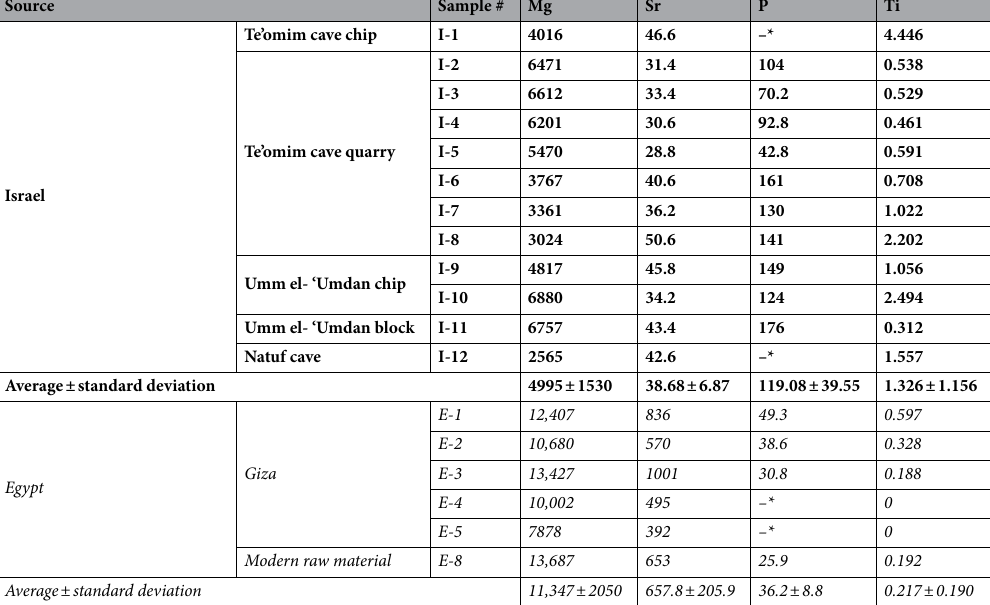
Table 1. ICP-AES results (in ppm). Israeli samples in bold, Egyptian samples in italics. *Data not